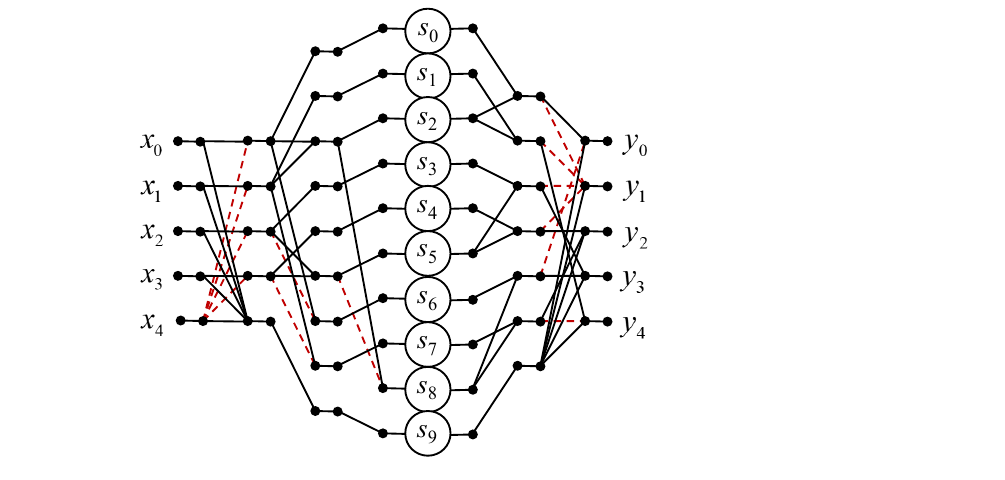
Figure 4. Algorithmic structure of the processing core for the computation of the 5-point circular